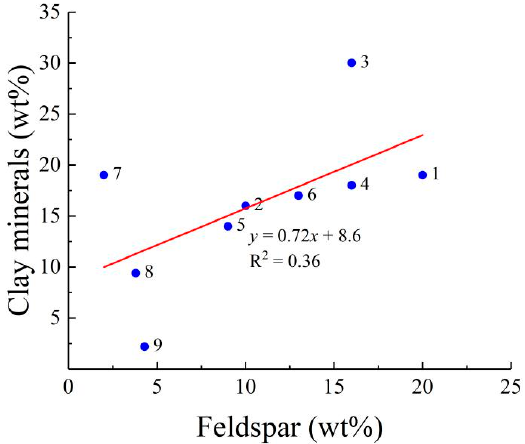
Figure 15. The relationship between the content of clay minerals and feldspar content.